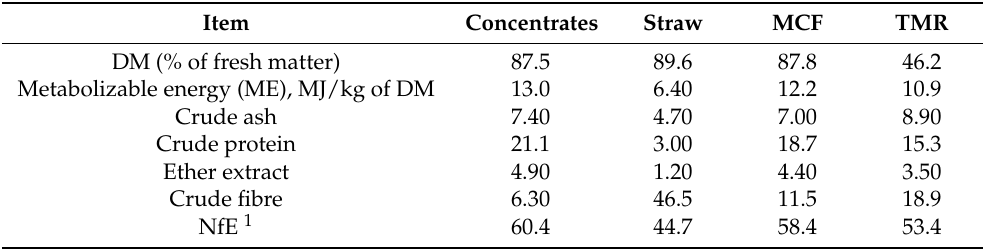
Table 2. Energy content and chemical composition (% DM unless stated) of concentrates, straw, mixed calf feed (MCF; 87% concentrates and 13% straw), and total mixed ration (TMR) was